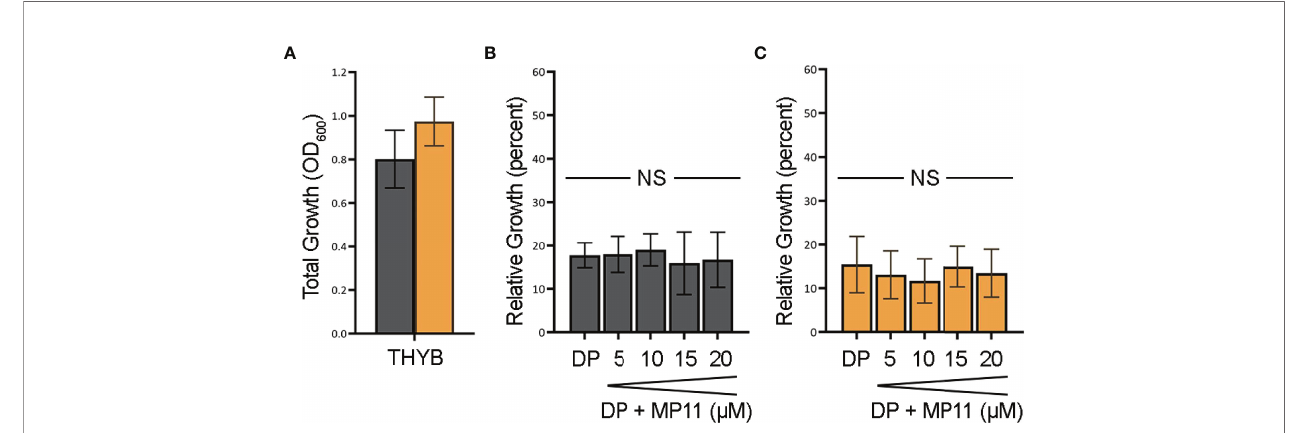
FIGURE 5 | GAS cannot use MP11 as an iron source. Overnight growth of GAS wild-type rescue (gray) and D hupZ (orange) strains in THYB (A) . Relative growth of GAS wild-type rescue THYB-DP with a range of MP-11 compared to THYB growth (B) . Relative growth D hupZ under the same conditions (C) . No signi fi cance was determined using the Student ’ s t -test. NS, not signi